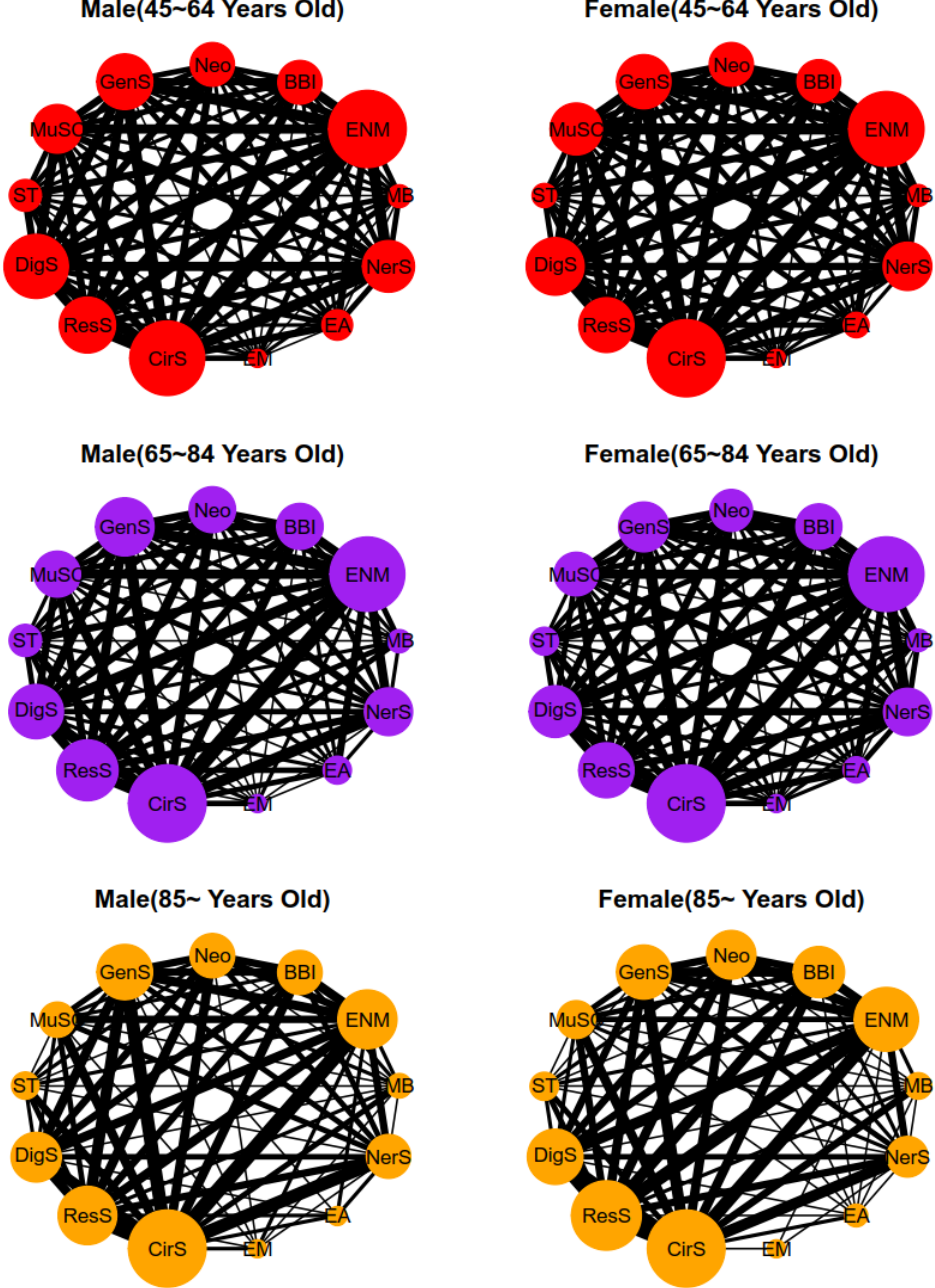
Figure 4. Multimorbidity networks by age group for 13 systemic diseases.